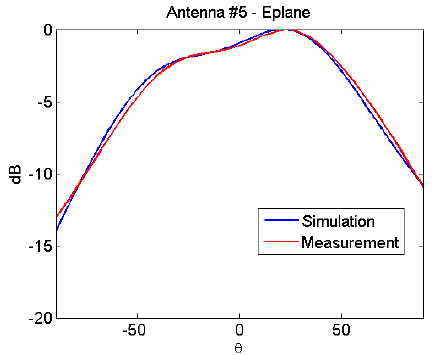
Figure 8. Comparison between measurements and simulations for antenna configuration (cid:93) 5 (upper left patch “OFF”)—E plane.